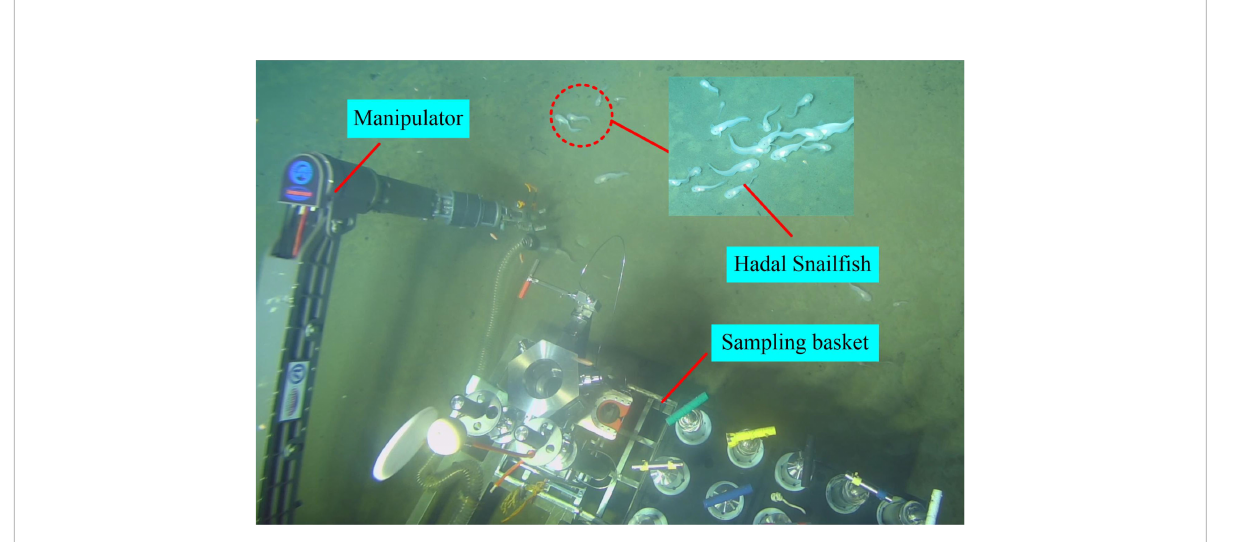
FIGURE 1 Fendouzhe manned submersible catches hadal snail fi